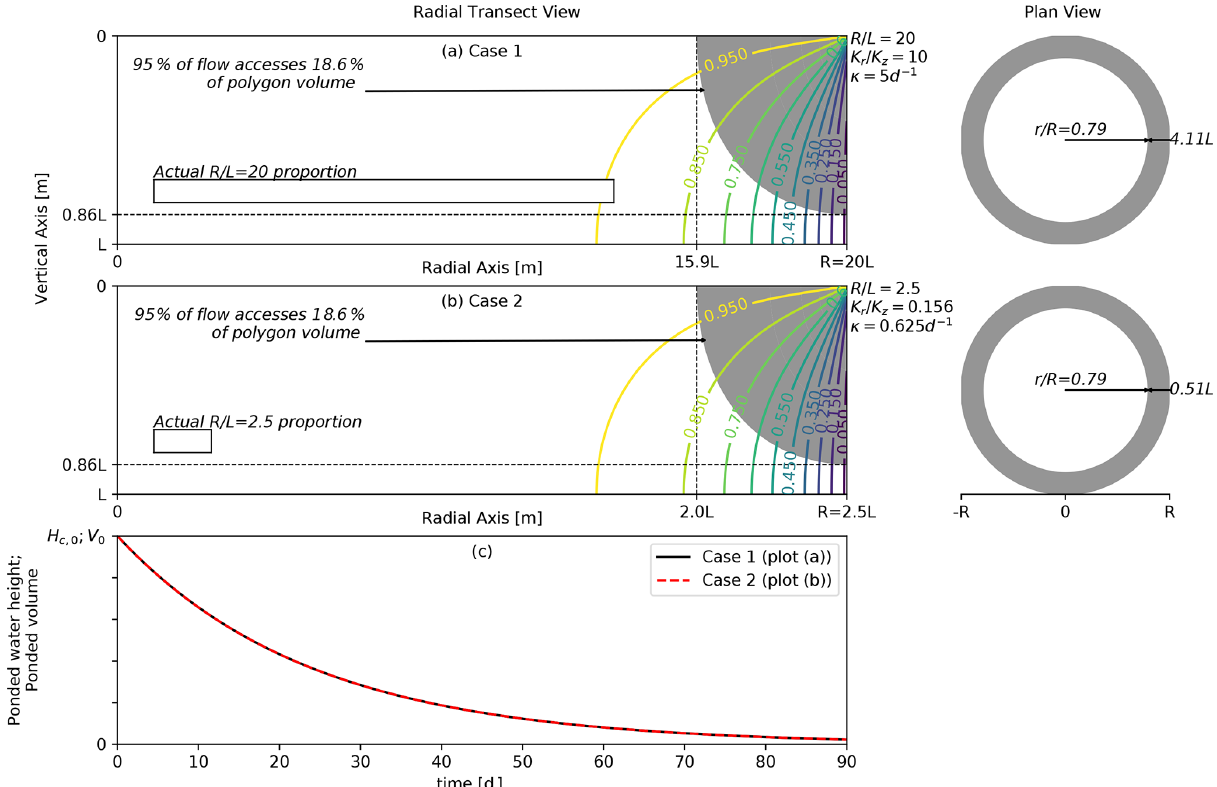
Figure 11. Attaining the same mathematical solution by modifying polygon aspect ratio ( R/L ), anisotropy coefficient ( K r /K z ), and rim conductance ( κ ). The left plots of (a) and (b) contain polygon radial transect head contours (colored lines) and filled stream tubes (gray regions) for several polygon aspect ratios (radius/thickness). The gray shaded region denotes the portion of the transect accessed by 95% of the flow. The right plots of (a) and (b) contain corresponding gray rings indicating the surface area where 95% of the polygon flow infiltrates. Plots (a) and (b) contain a rectangle drawn to the actual proportions for the given polygon aspect ratio. The ponded water height and volume depletion curves for both cases are presented in (c)